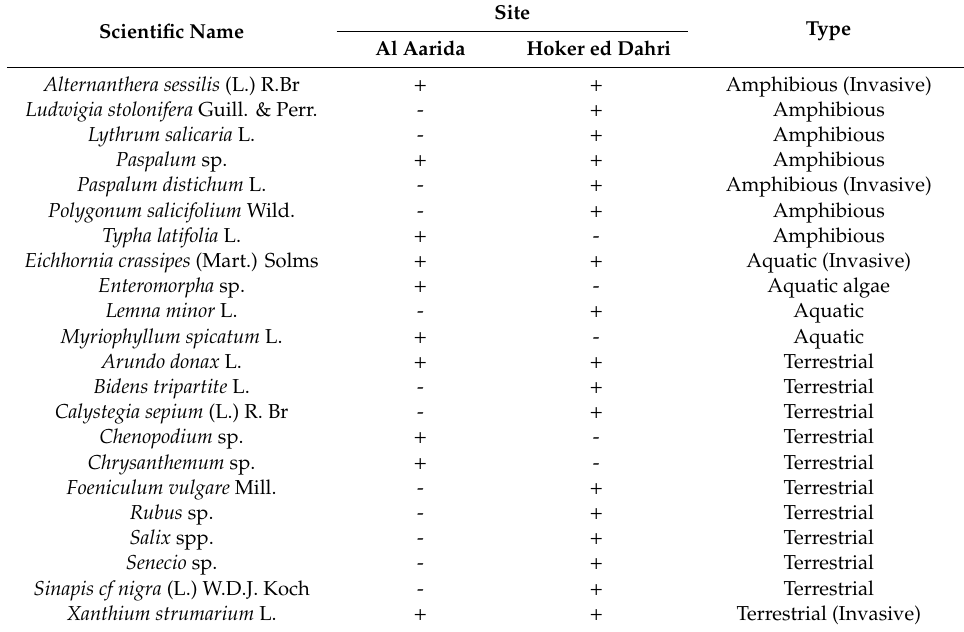
Table 4. Presence ( + ) or absence ( − ) of plant species at the two sites of the study area in 2017–2018.